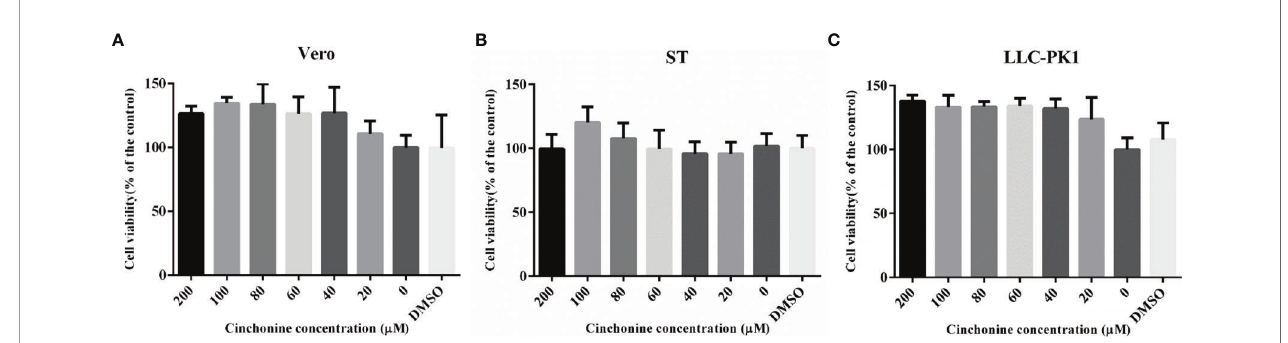
FIGURE 1 | The cytotoxicity of cinchonine on Vero CCL81, ST and LLC-PK1 cells. (A) Vero CCL81 cell, (B) ST cell or (C) LLC-PK1 cell viability was evaluated by CCK-8 assay. All the values were normalized to the control, which represents 100% cell viability. The representative result of at least three independent experiments has been indicated. The data has been shown as mean ± standard